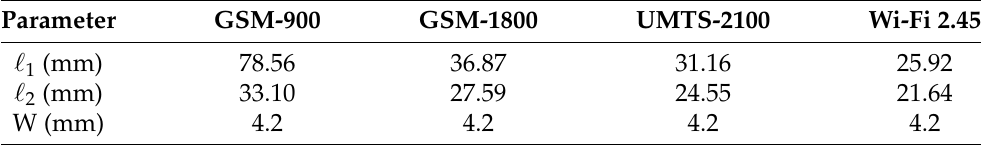
Table 1. Dimensions of transmission lines and microstrip